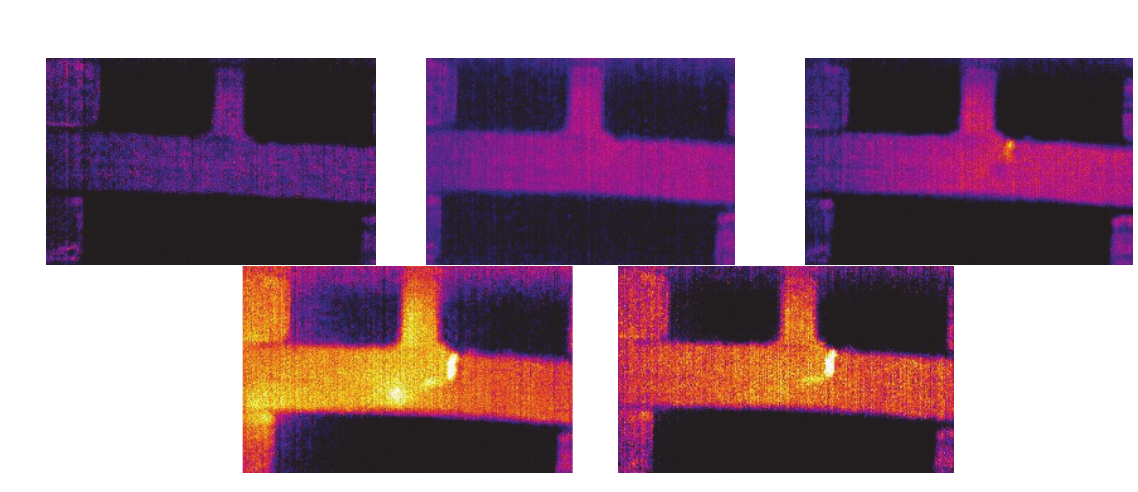
Figure 11: Thermal images during the test at 20 kN.